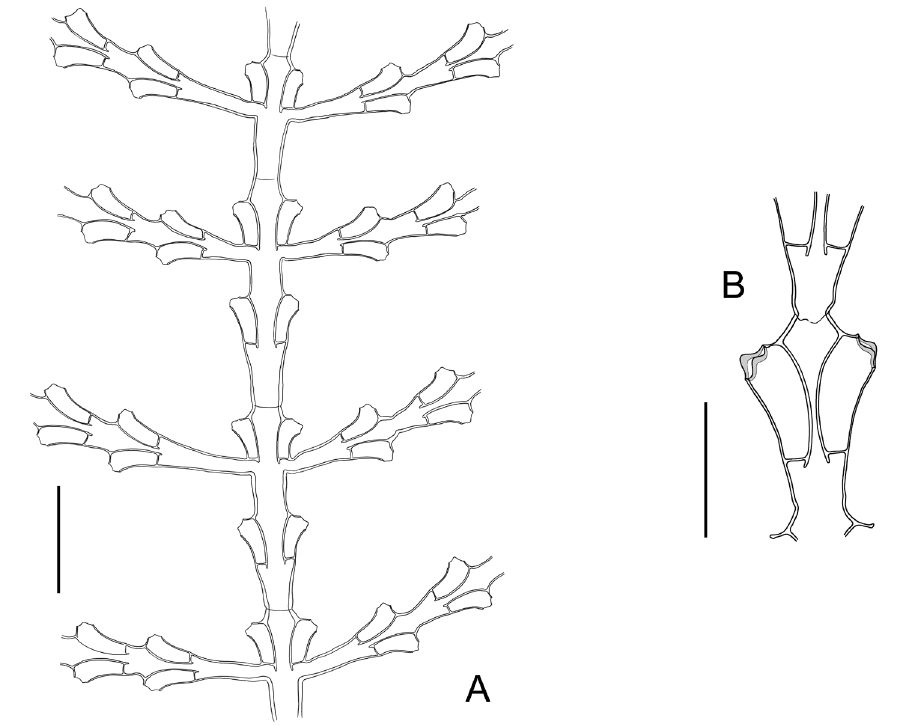
Fig. 11. Dynamena opposita Galea, sp. nov. A–B . Distal part of colony showing branching pattern (A), cladial internode with pair of hydrothecae (B). Scale bars: A = 1 mm; B =